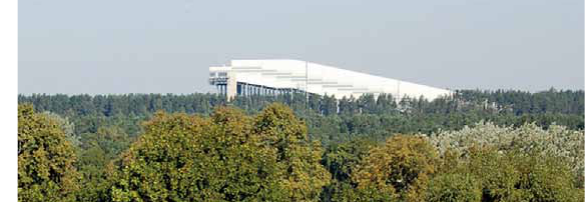
fig. 9. The realization of the project on Snow arena in covering: the view of the